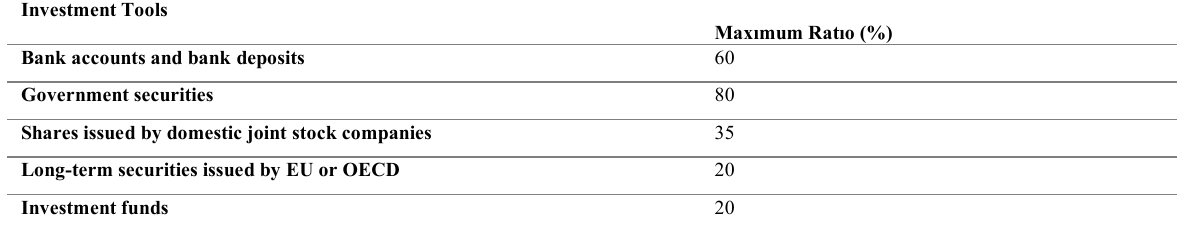
Table 5: Assets that insurance companies can invest in